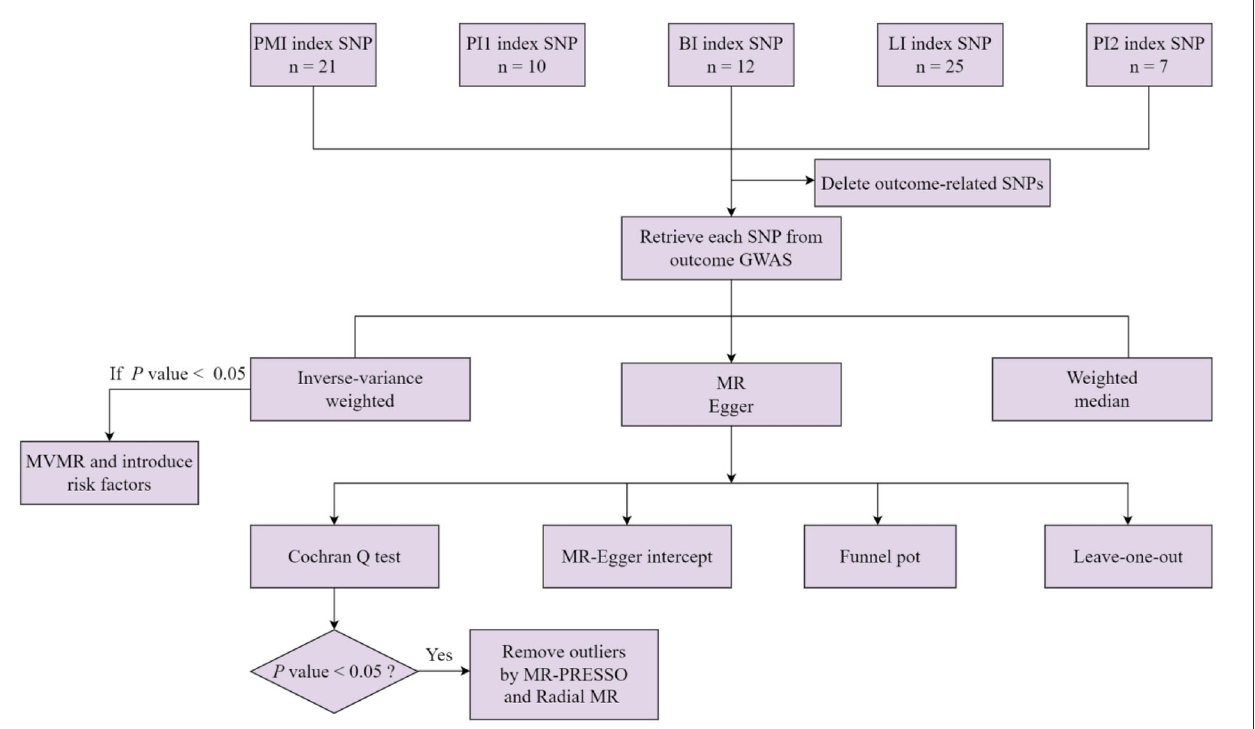
FIGURE1 A flowchart for the MR analysis of five types of meat intake and digestive tract cancers. PMI, processed meat intake. PI1, pork intake. BI, beef intake. LI, lamb intake. PI2, poultry intake. MVMR, multivariable Mendelian